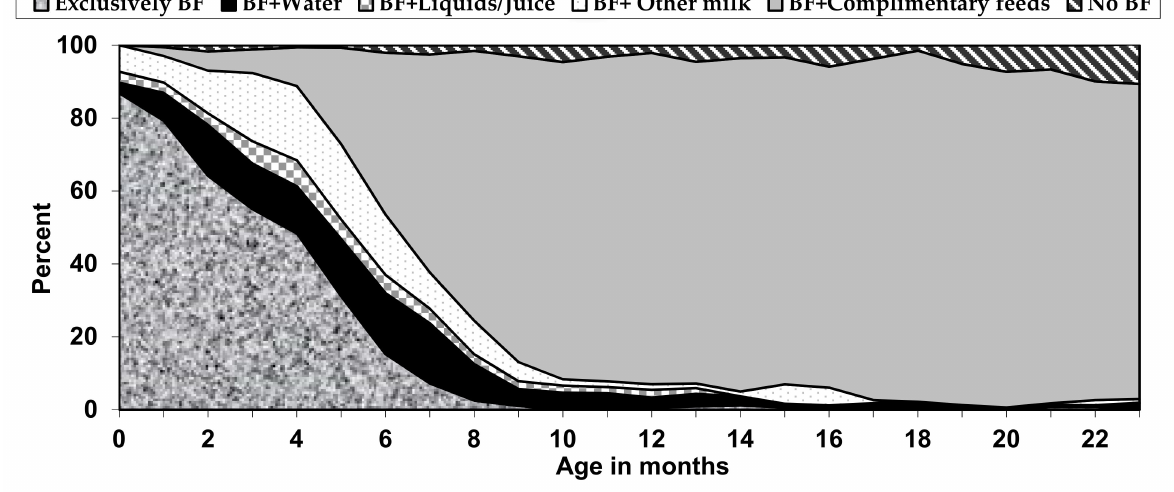
Figure 1. Distribution of children born to adolescent mothers by breastfeeding (BF) status, according to age in Bangladesh 2004–2014 (n =